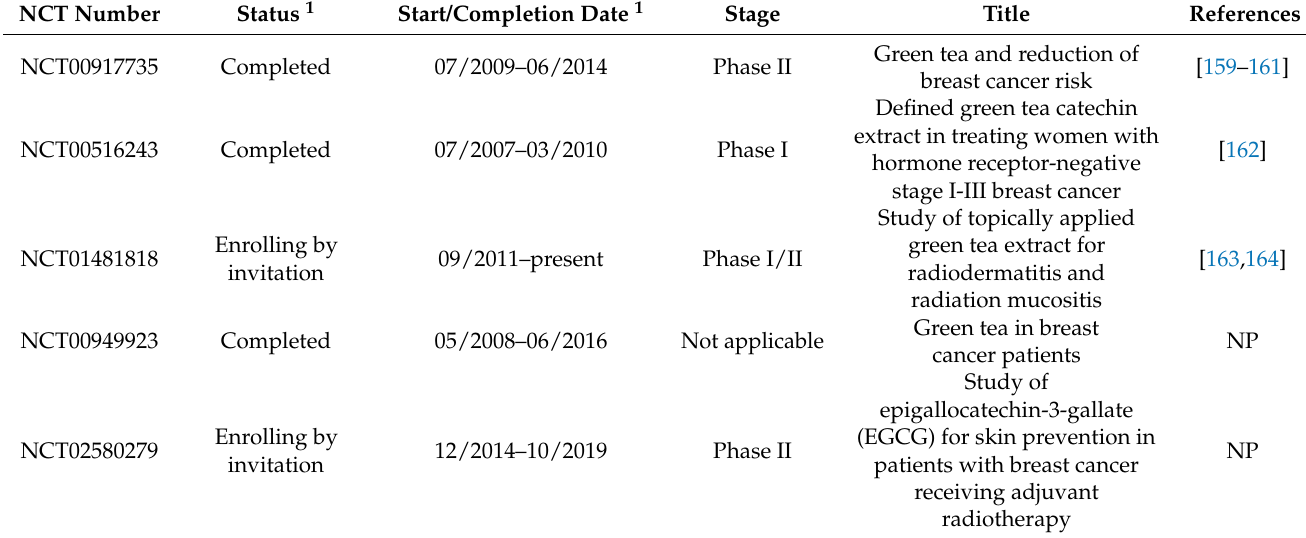
Table 9. Clinical trials with epigallocatechin gallate (EGCG) in breast